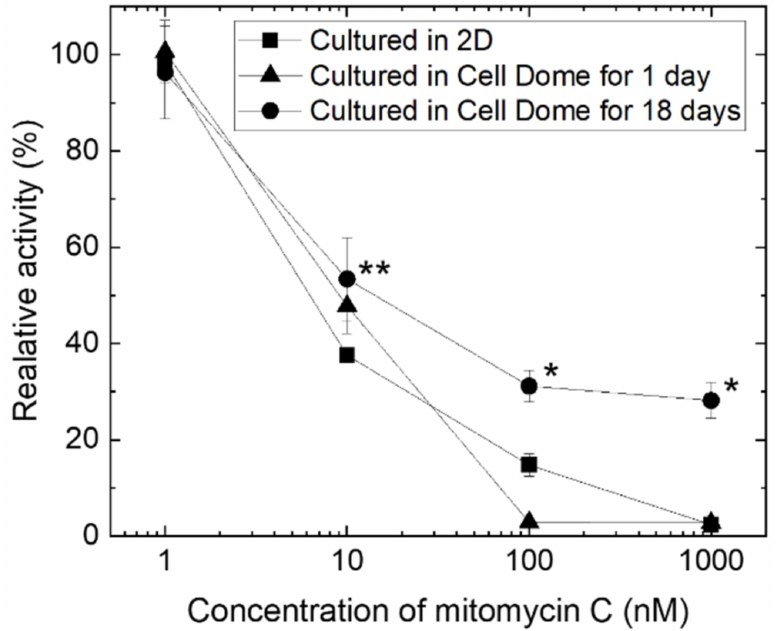
Figure 5. Relative activity of 2D-cultured cells on a tissue culture dish ( (cid:4) ), the cells in Cell Dome after 1 day of culture ( (cid:78) ), and hemispherical cell aggregates formed in Cell Dome after 18 days of culture ( • ). Bars: SD, n = 3~5, * p < 0.05 vs. 2D-cultured cells and those in Cell Dome after 1 day of culture, ** p < 0.05 vs. cultured in 2D-cultured